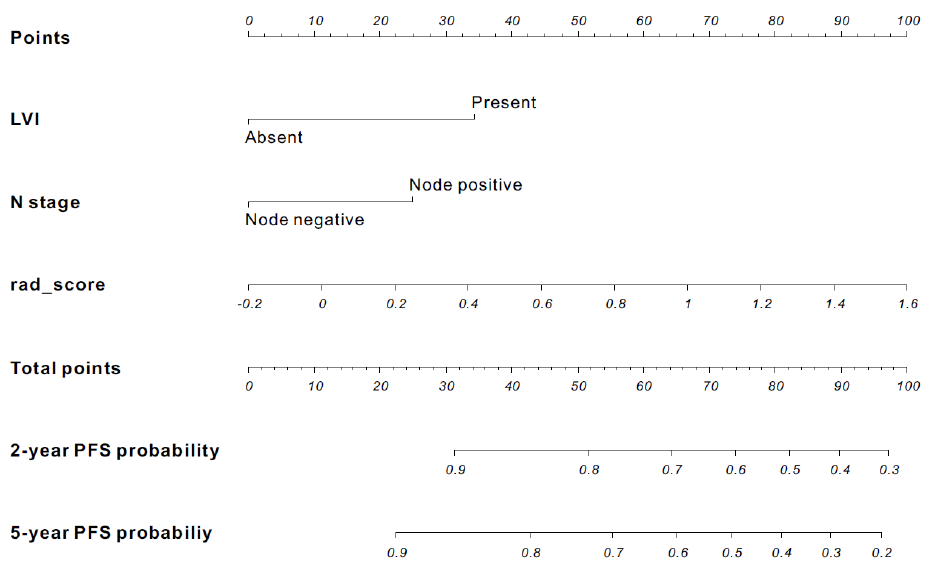
Figure 2. Developed nomogram to predict survival using the training set. Drawing a vertical line to the points’ axis from specific variable could determine how many points toward the probability of PFS the patient receives. The process was repeated for each variable, such as LVI, N stage, and rad_score. The points for each of the risk factors were added. The final total was then located on the total points axis.